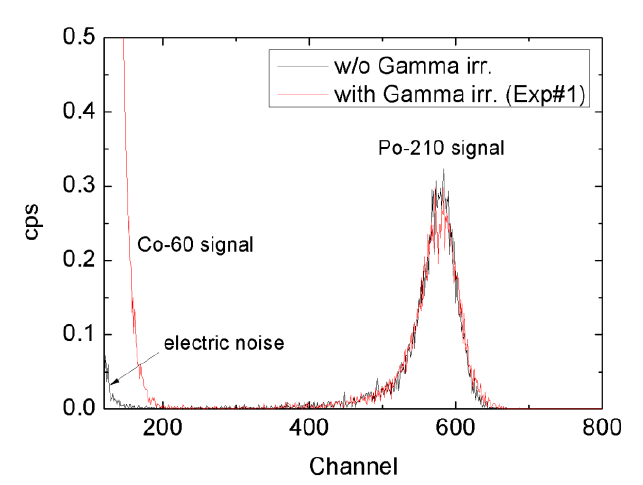
Fig. 6. The alpha and gamma signals before and during gamma